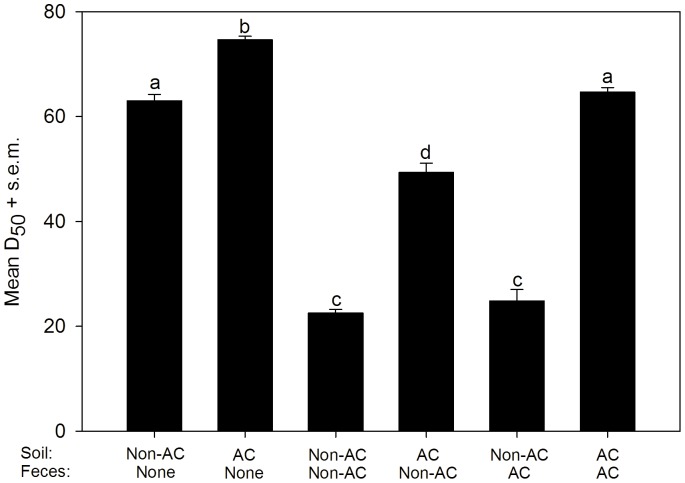
Soil mircoflora is responsible for degradation of ceftiofur metabolites.Effect of autoclaved (AC) vs. non-autoclaved (non-AC) soil and feces on ceftiofur metabolites (CFM) as measured by recovery of growth for E. coli K-12 (D50). Sandy soil was used and chambers were incubated at 4°C. Main effects (soil and feces) were significant (P<0.0001). Letters designate group differences based on Tukey-Kramer multiple comparison test (P<0.001). Bars = s.e.m.